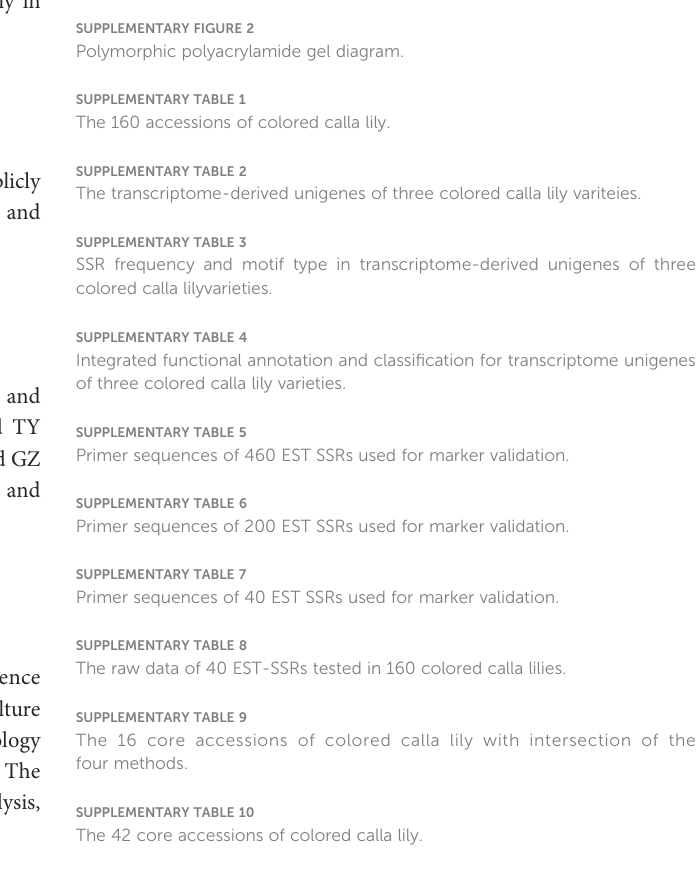
SUPPLEMENTARY FIGURE 2 Polymorphic polyacrylamide gel diagram.